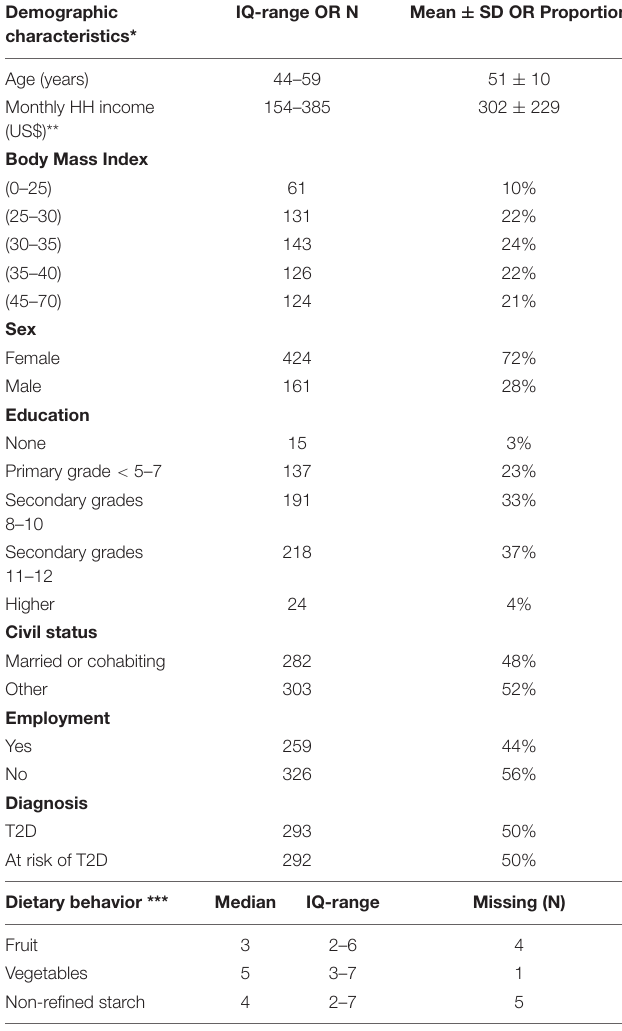
TABLE 1 | Summary statistics of socio-demographic and dietary behavior characteristics of the study population ( N = 585). Demographic